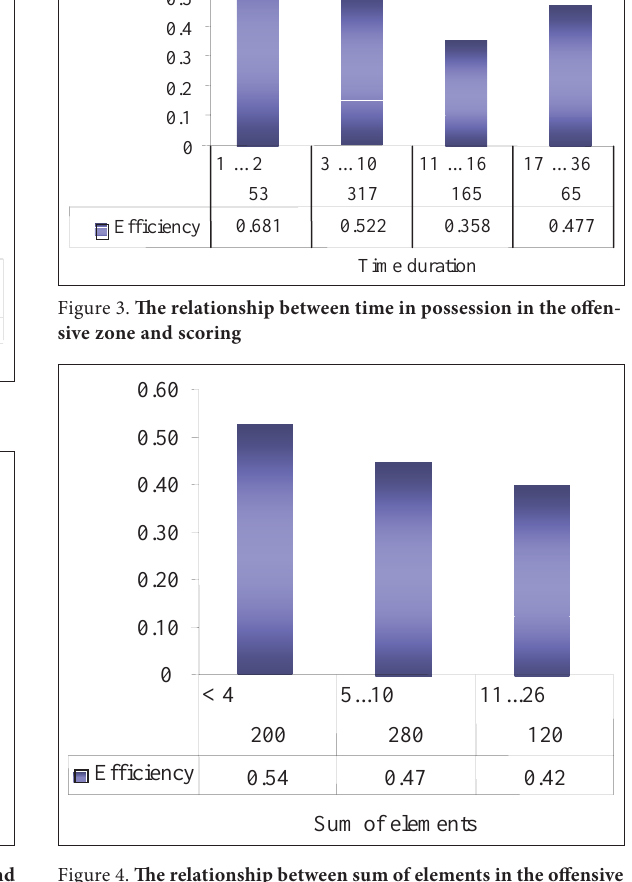
Figure 2. Th e relationship between total time in possession and scoring